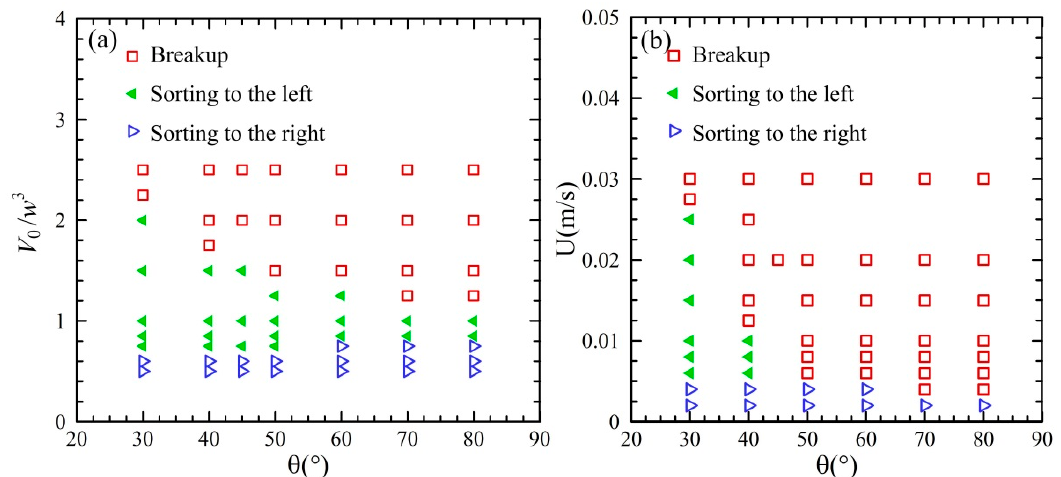
Figure 12. Phase regime of droplet sorting in the asymmetric acute junctions: ( a ) U = 20 mm/s and ( b ) V d / w 3 = 2.